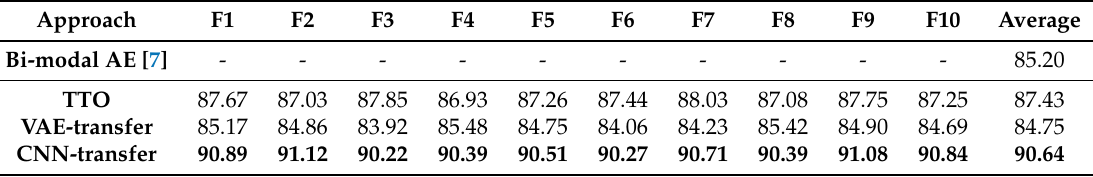
Table 8. 10-fold cross validation accuracies (in %) for the classification of VALENCE using a multichannel DNN on the DEAP dataset. F i refers to fold number i . The best performance for each fold is highlighted in